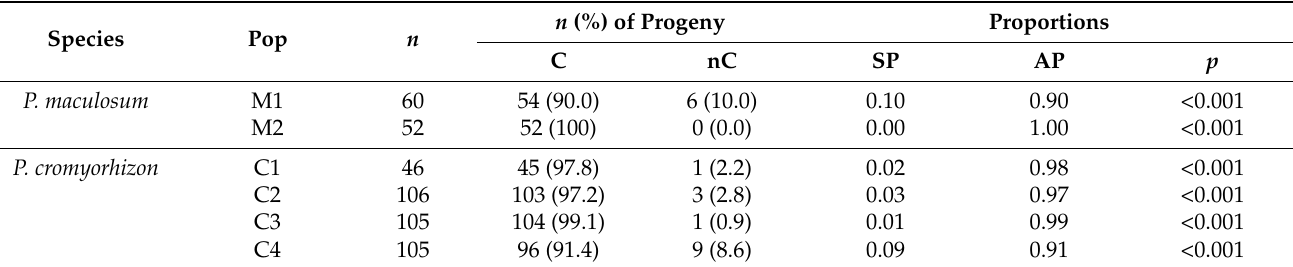
Table 3. Observed number and percentages (%) of progenies genotypically clonal (C) and non-clonal (nC) to their apomictic genotype progenitor in tetraploid P. maculosum and P. cromyorhizon with three mutational steps (S = 3), and the observed proportions of the sexual (SP) and apomictic (AP) pathway at the progeny stage.